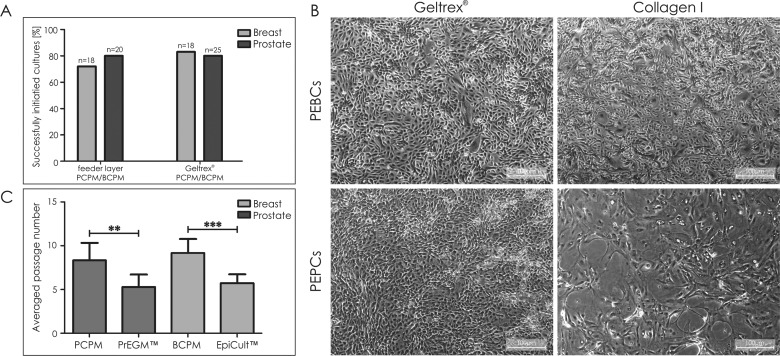
Culturing of PEPCs and PEBCs(A) Establishment of primary epithelial cancer cultures in tissue-specific primary cell media on Geltrex® or feeder layer–efficiency comparison. (B) Exemplary PEPCs or PEBCs cultured in PCPM/BCPM on Geltrex® or collagen I coating. (C) Averaged passage number of PEPCs and PEBCs cultured in tissue-specific and commercial primary cell media. Errors bars indicate SEM. Statistical significance calculated using two-tailed t-test; **P  <0.01, ***P  <0.001.